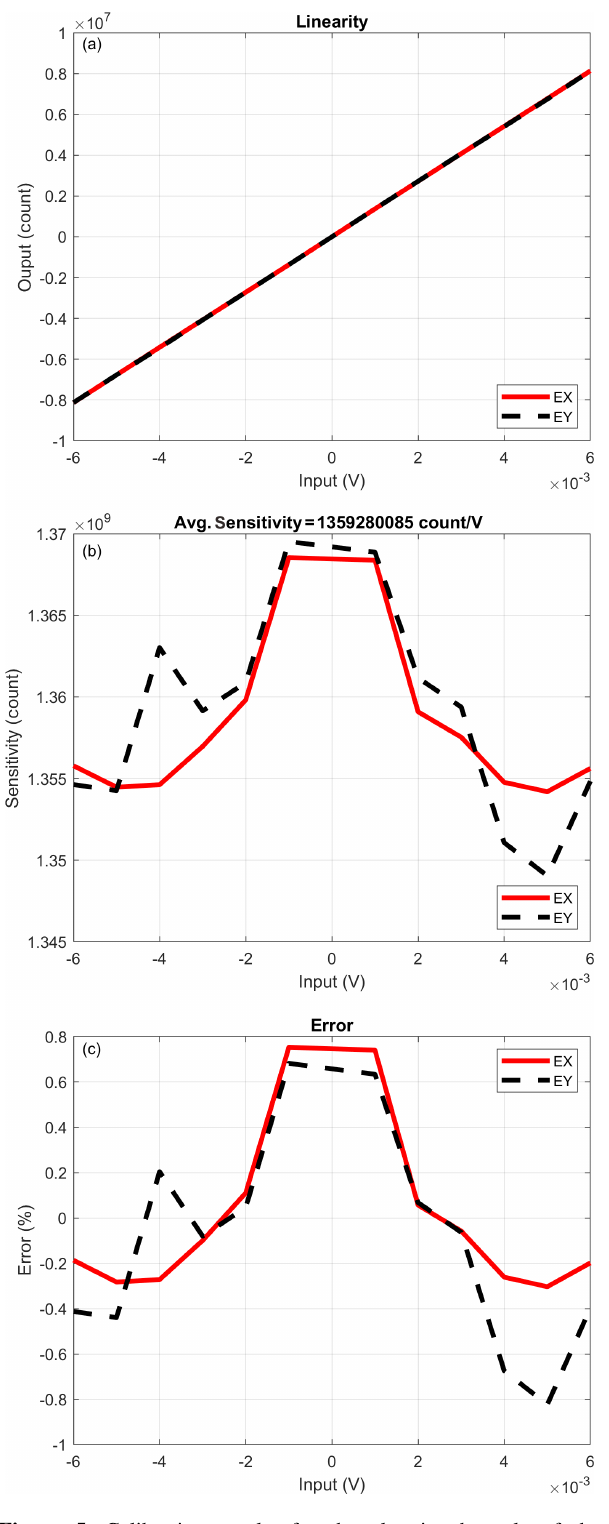
Figure 6. Calibration results for the inclination channels of the OBEM01. (a) Linearity, (b) sensitivity and (c) error. The average sensitivity is 1677710.6countsV − 1 , and the maximum error is <